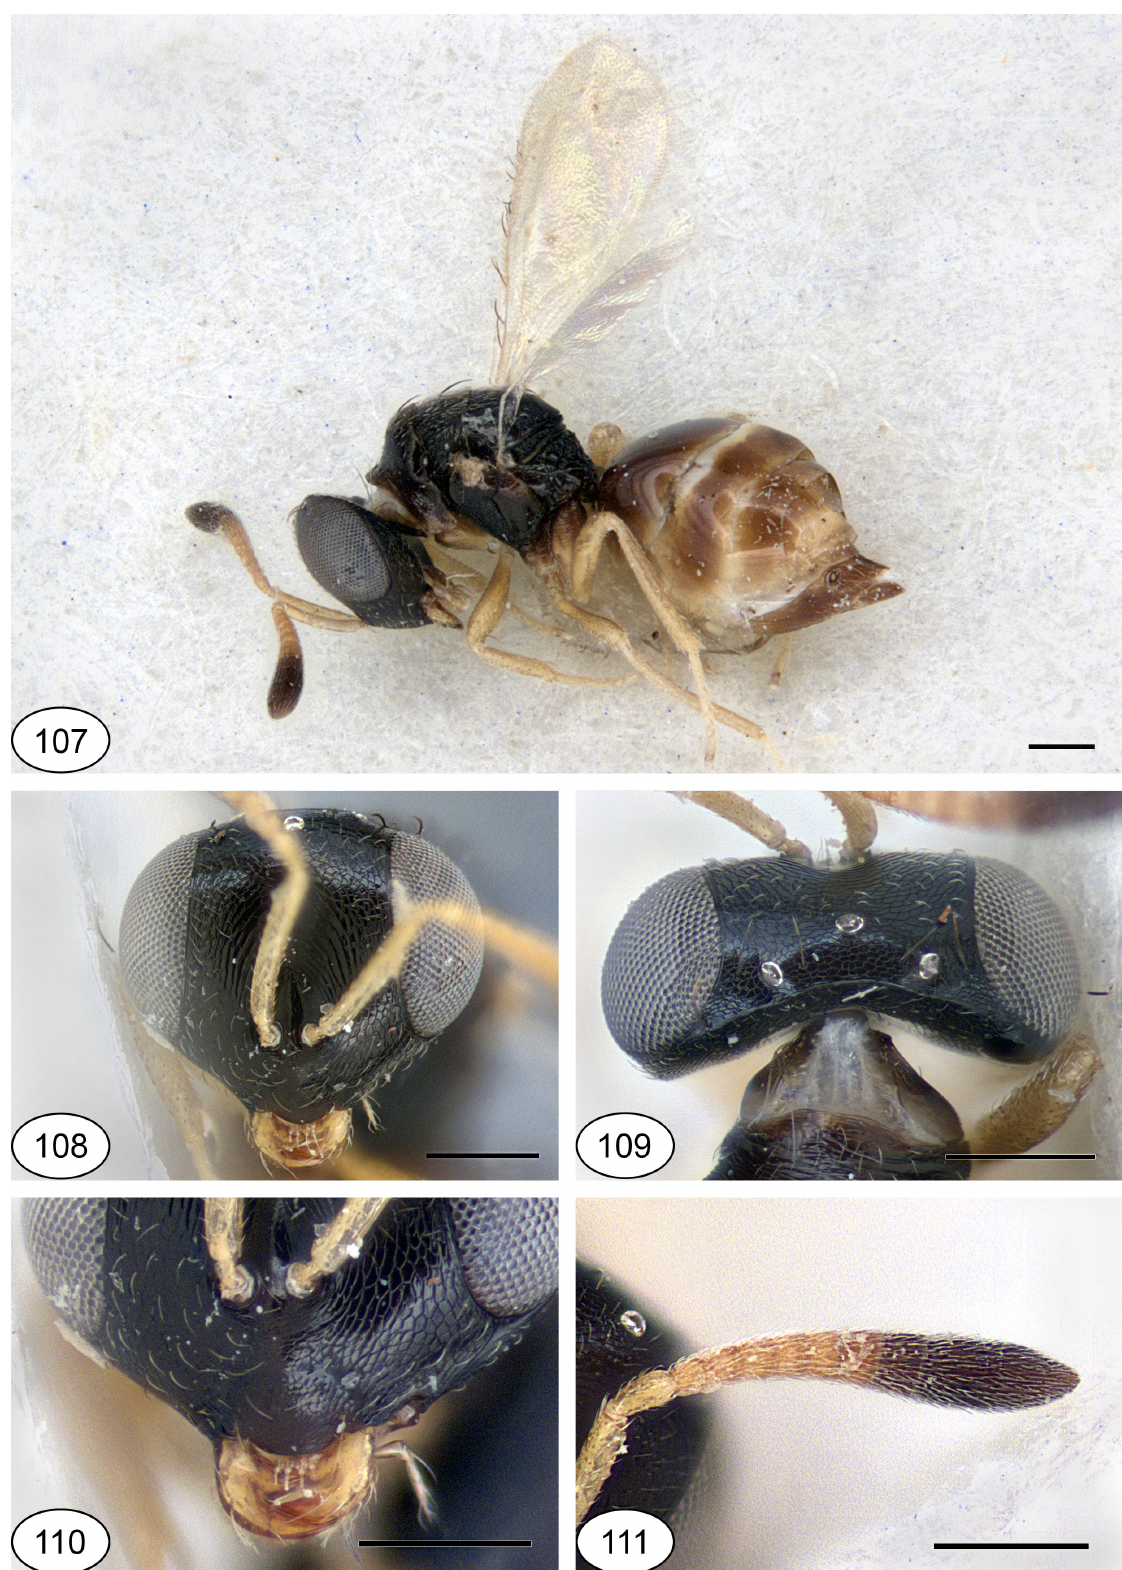
Figs 107–111. Netomocera merida sp. nov., holotype, ♀. 107 . Habitus, lateral view. 108 . Head, frontal view. 109 . Head, dorsal view. 110 . Lower face. 111 . Antenna. Scale bars: 0.2